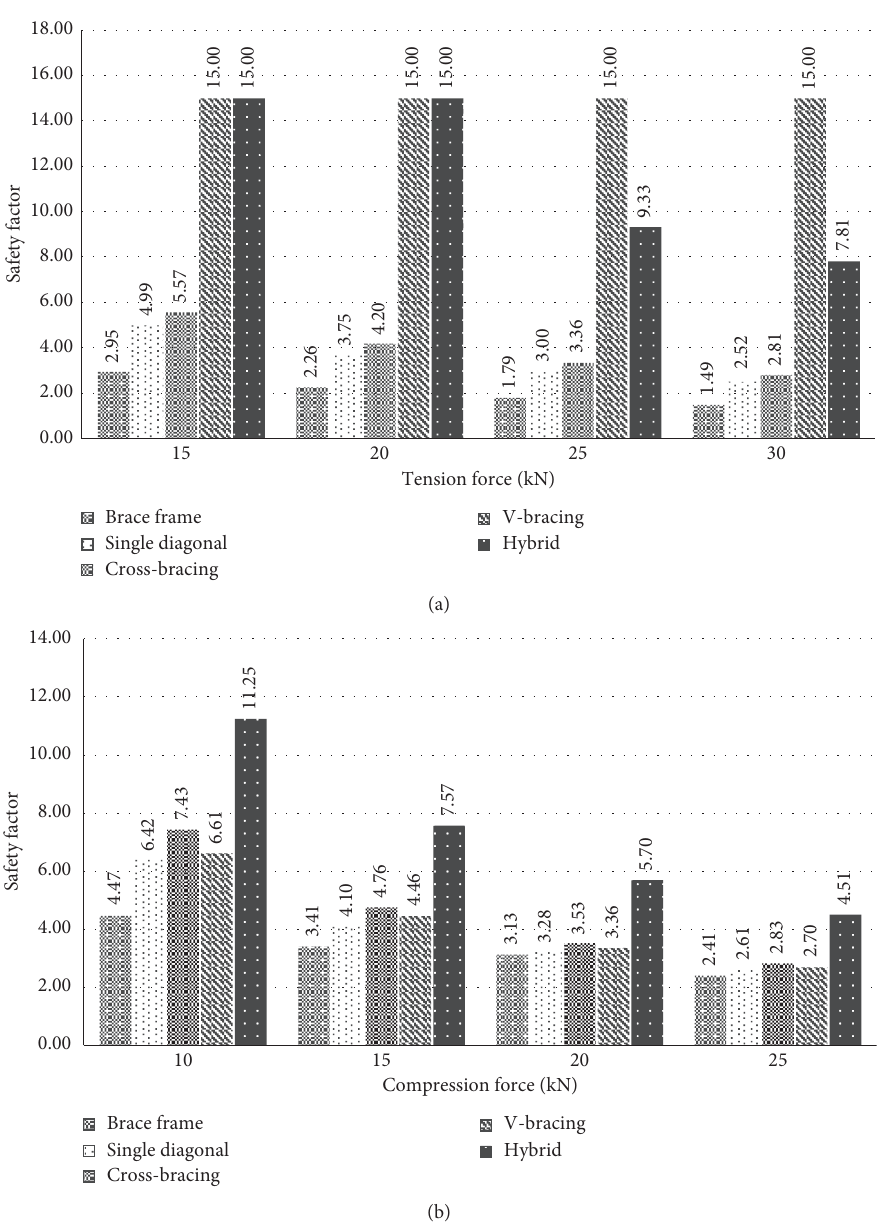
Figure 8: Safety factor analysis at: (a) tie member (tension force) and (b) main member (compression force)